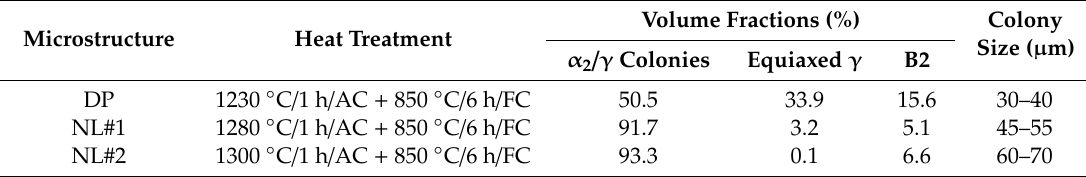
Table1. Heattreatmentroutesandvolumefractionsoftheconstituentsofthreedi ff erentmicrostructures.